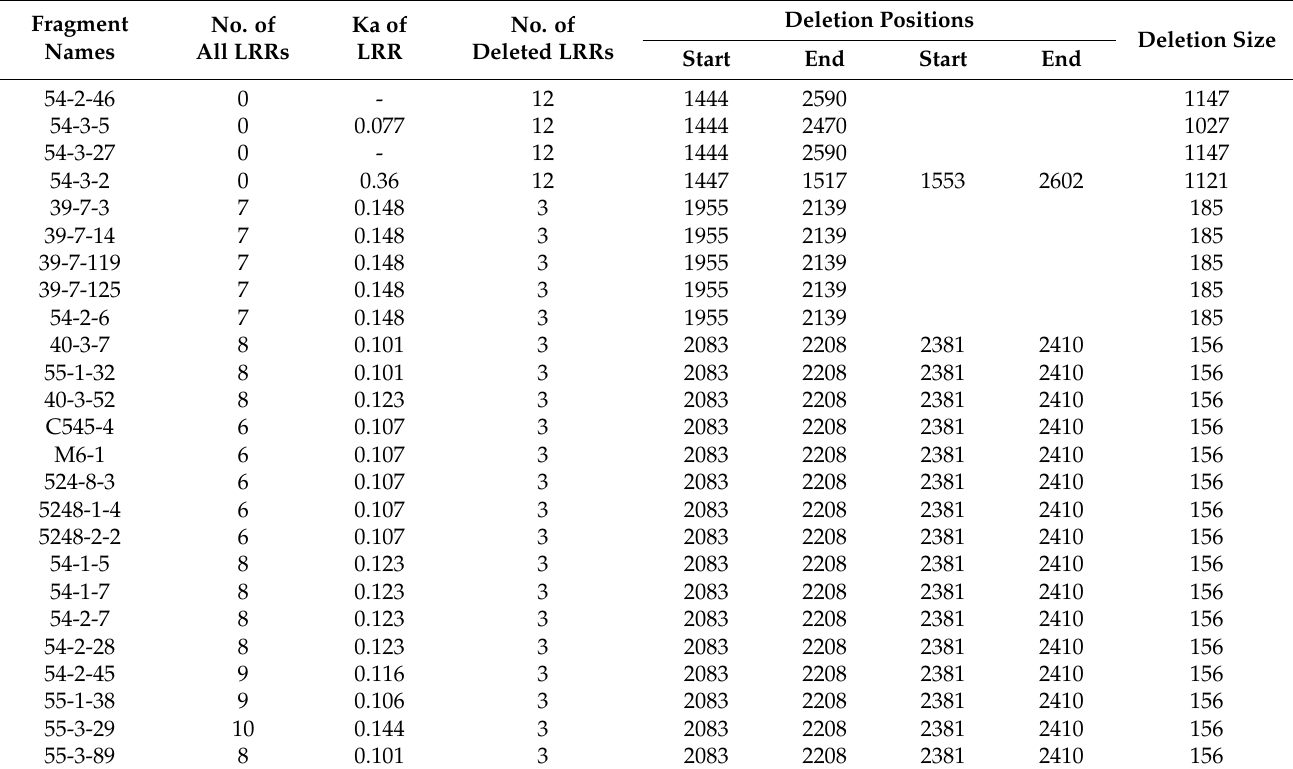
Table 1. Large deletions and point mutations in the LRR